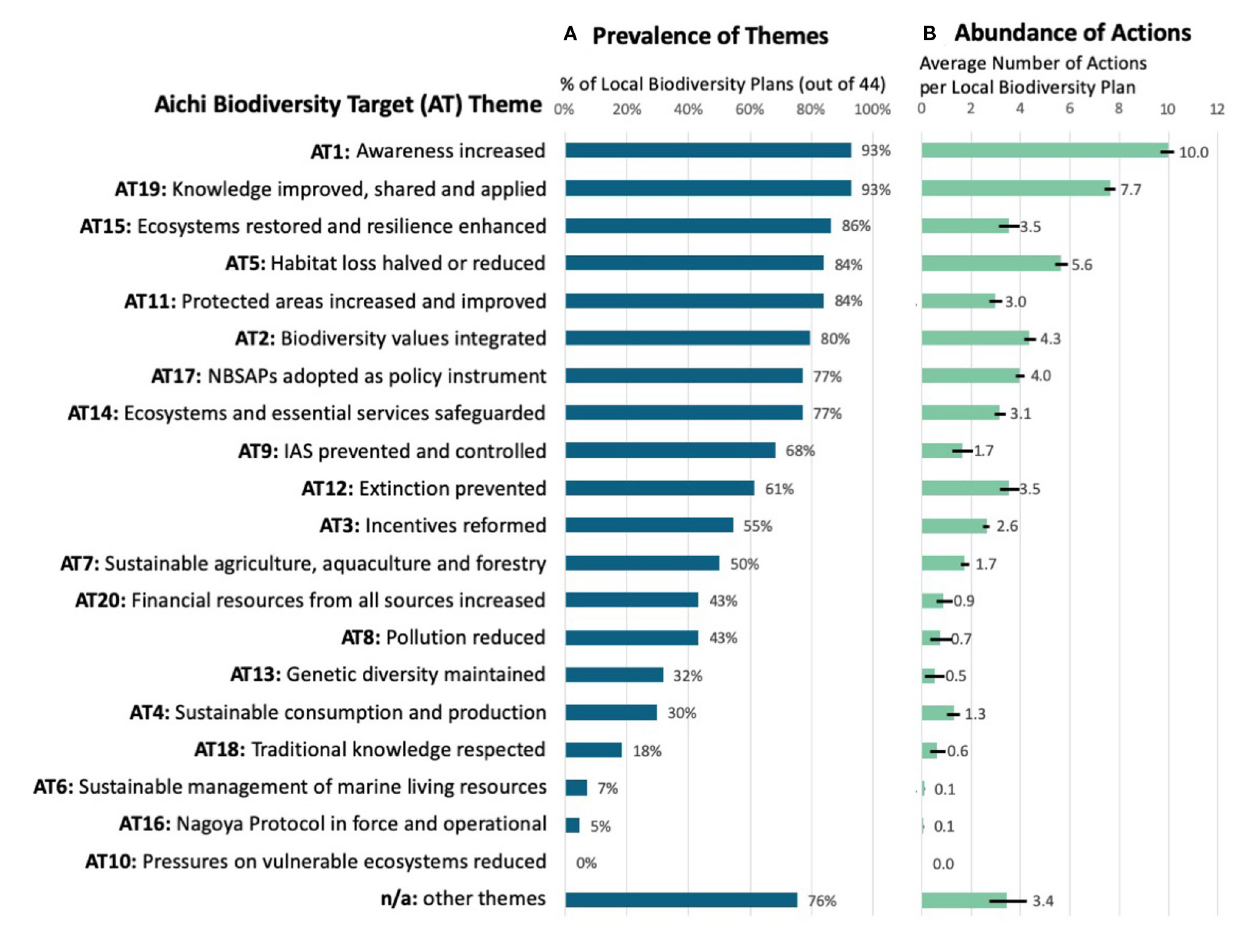
FIGURE 1 | Prevalence of Aichi Biodiversity Target (AT) themes in local biodiversity plans (A) and Average Number of Actions per plan by Aichi Target Themes (B) .